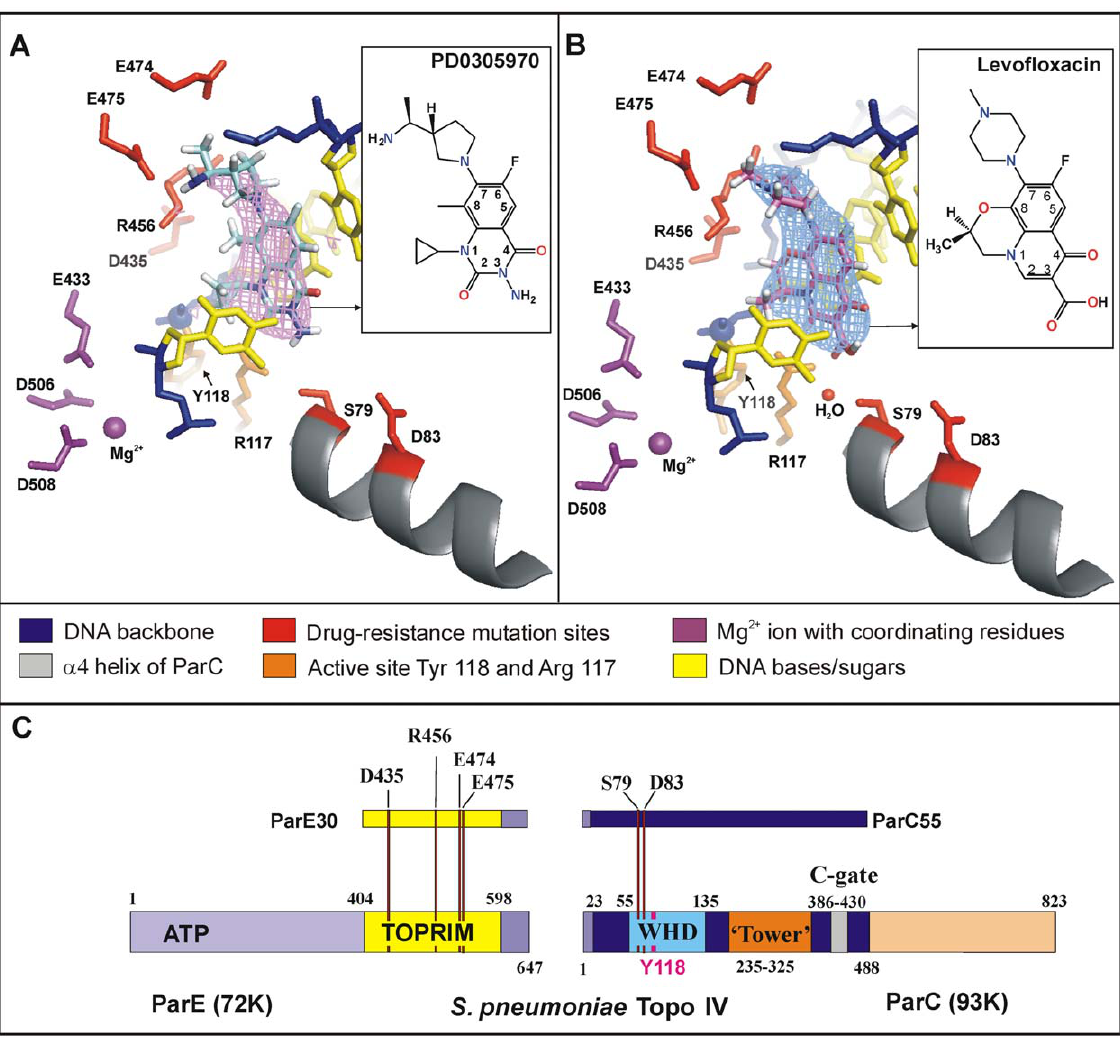
Figure 2. Unique interactions govern topoisomerase IV arrest on DNA. A and B , Cartoon/stick representation of the drug-binding pockets of topoisomerase IV-DNA in complex with PD 0305970 and levofloxacin, respectively. The s A-weighted 2F obs -F calc map is contoured around PD 0305970 (pink) and levofloxacin (light-blue) at 1.5 s . C , Domain organization of topo IV from S. pneumoniae with individual sub-regions highlighted by individual colours. Resistance mutation sites within the topoisomerase sequence are indicated by red lines.